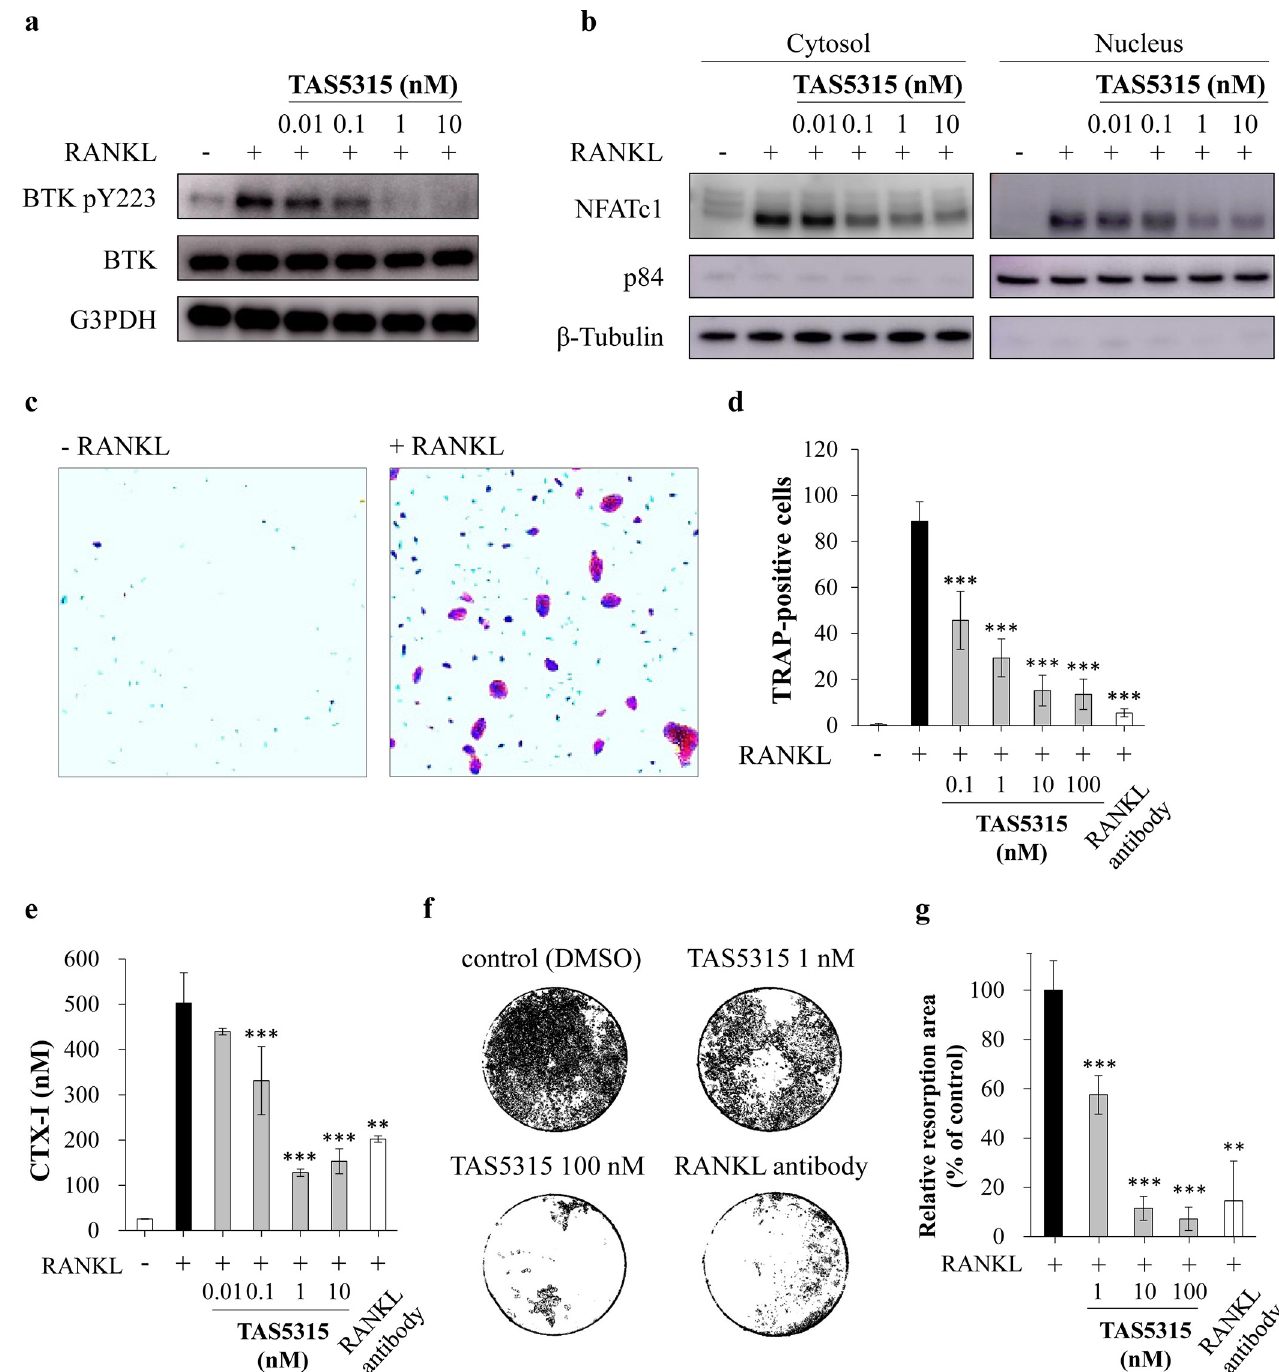
Fig 3. Effect of TAS5315 on macrophages and osteoclasts. (a) Phosphorylation of BTK induced by RANKL stimulation (100 ng/mL) for 24 h in M-CSF- induced murine macrophages. Macrophages were simultaneously subjected to TAS5315 and RANKL stimulation. (b) Nuclear translocation of NFATc1 induced by RANKL stimulation (100 ng/mL) for 24 h in M-CSF-induced murine macrophages. M-CSF-induced murine macrophages were simultaneously subjected to TAS5315 and RANKL stimulation. The figures of immunoblot experiments (a, b) represent the data of three independent experiments. (c, d) Human osteoclast differentiation was induced by RANKL (66 ng/mL) and M-CSF (33 ng/mL) in the presence of DMSO, TAS5315, or anti-RANKL antibody (0.1 μ g/mL) for 4 days. (c) Representative images of TRAP-positive osteoclasts. (d) TRAP-positive cells with 3 or more nuclei (cell size � 50 μ m) were counted as osteoclasts. (e) CTX-I levels in the supernatant of human osteoclasts treated with M-CSF (33 ng/mL) and RANKL (66 ng/mL) in the presence of DMSO, TAS5315, or anti-RANKL antibody (0.1 μ g/mL) for 14 days. (f, g) Pit formation by mouse osteoclasts treated with RANKL (25 ng/mL) and M-CSF (50 ng/mL)